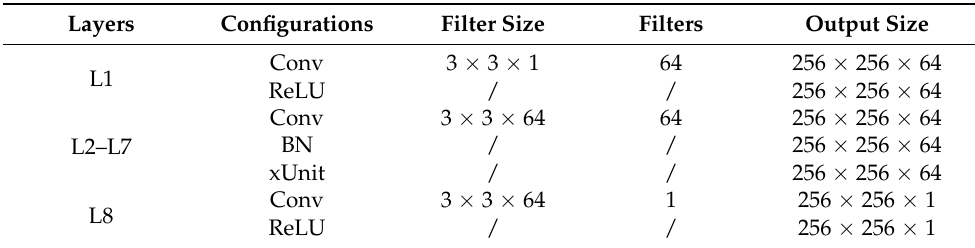
Figure 6. The process of the proposed method: ( a ) the process of simulated SAR image, ( b ) the proposed CNN architecture for SAR image despeckling. Table 1. The network